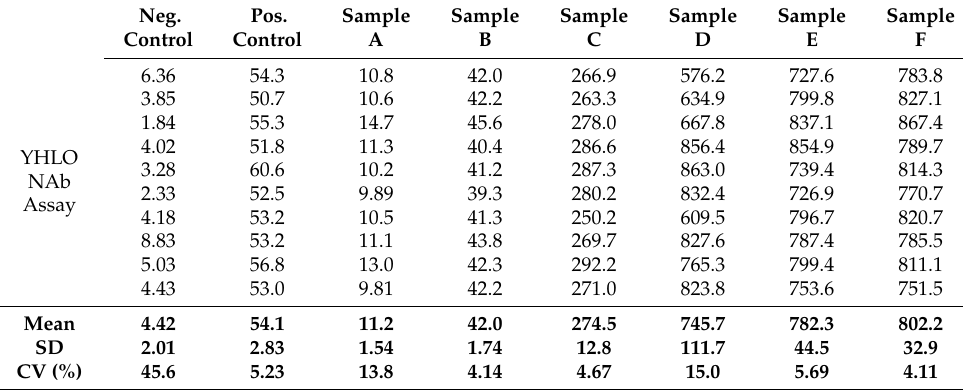
Considering only samples obtained ≥ 14 days since diagnosis, a weak but signifi- cant decay in NAb titers was observed over time in moderate–severe COVID-19